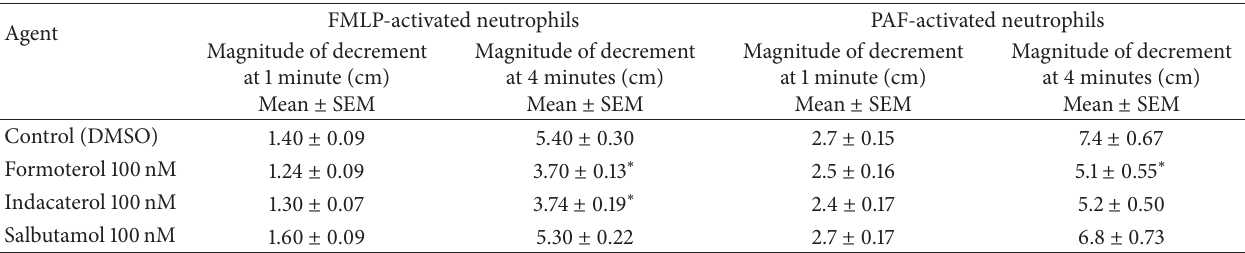
Figure 4: Effects of formoterol, indacaterol, and salbutamol (10 and 100nM) on the production of LTB 4 by fMLP- (a) and PAF- (b) activated neutrophils. The results of 5 separate experiments ( 𝑛 = 5 ) with 2 replicates for each drug concentration and control system in each experiment are expressed as the mean percentage of control ± SEM. The absolute values for the unstimulated control system and for cells activated with either fMLP or PAF were 33 ± 7 , 1095.4 ± 362.2 , and 1546 ± 1108.5 pg mL −1 . ∗ 𝑃 < 0.001 for comparison with the drug-free control systems. Table 2: Effects of formoterol, indacaterol, and salbutamol on Mn 2+ quenching of fura-2 fluorescence in FMLP- and PAF-activated